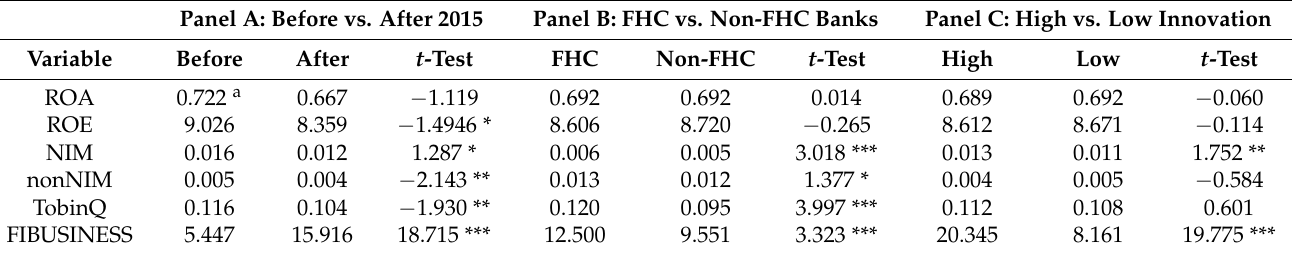
Table 3. The difference comparison t -test. Panel A: Before vs. After 2015 Panel C: High vs. Low